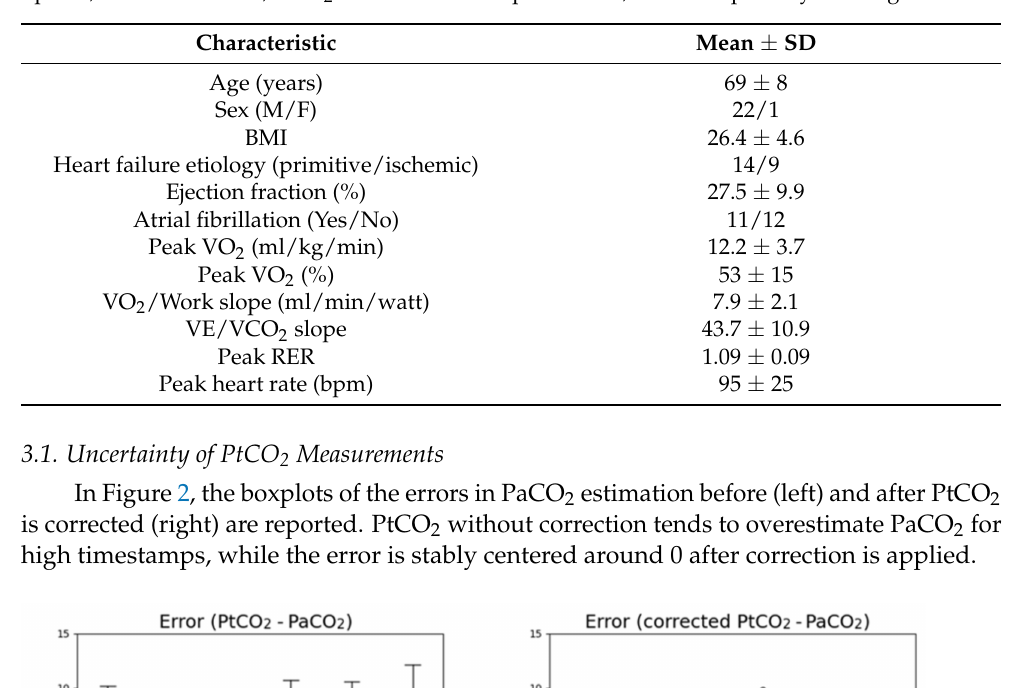
Table 2. Heart failure patient characteristics. Six subjects were tested twice. CPET data refer to 29 measurements. BMI = body mass index; CPET = cardiopulmonary exercise testing; VO 2 = oxygen